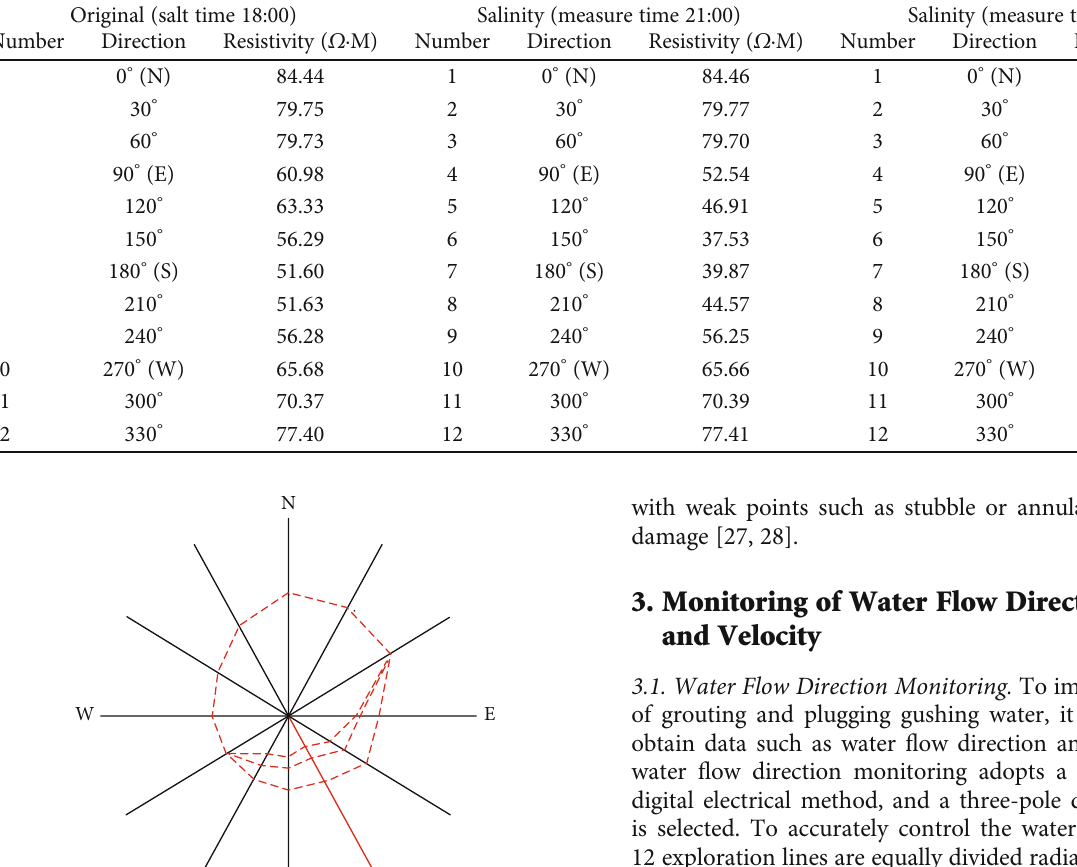
Table 1: Original record form.